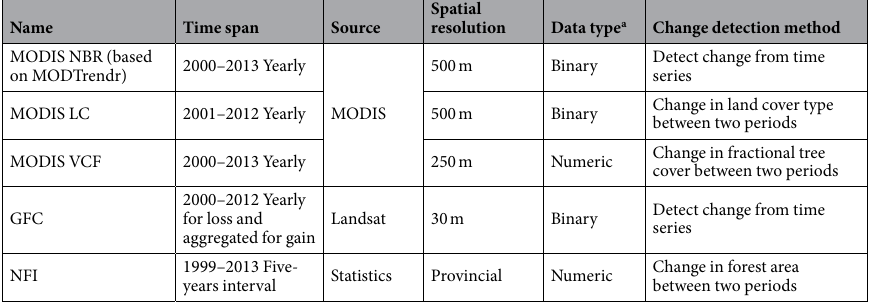
Table 1. Overview of different datasets employed for forest cover change estimates. a Binary: Change (loss or gain) or no change. Numeric: Change represented in units of